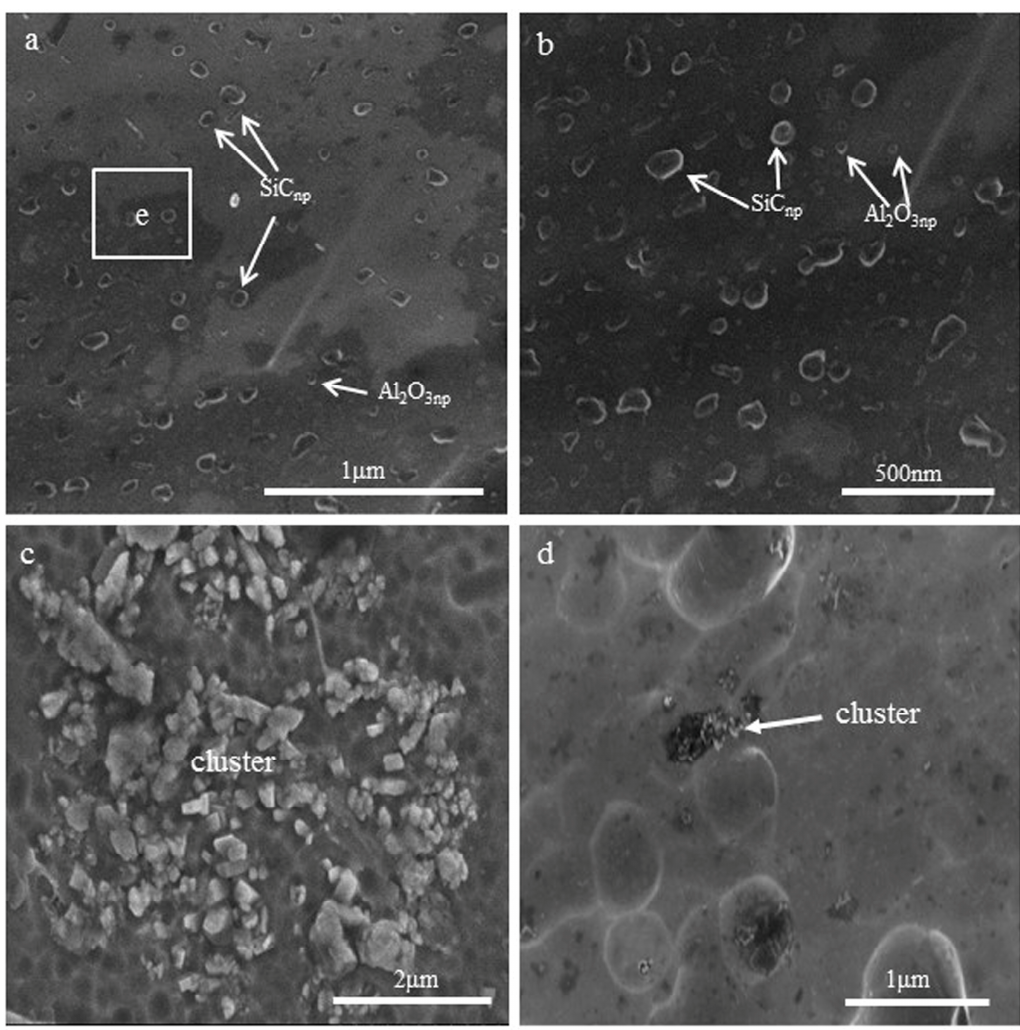
Figure 5. ( a ) Scanning electron microscope (SEM) image of the distribution of nanoparticles in Al 2 O 3np /SiC np /Al; ( b ) magnified image from the area marked as the rectangle e in (a). Large-sized particles are SiC np and small-sized particles are Al 2 O 3np ; ( c ) cluster in Al 2 O 3np /Al; and ( d ) cluster in SiC np /Al. The white arrows indicate clusters.